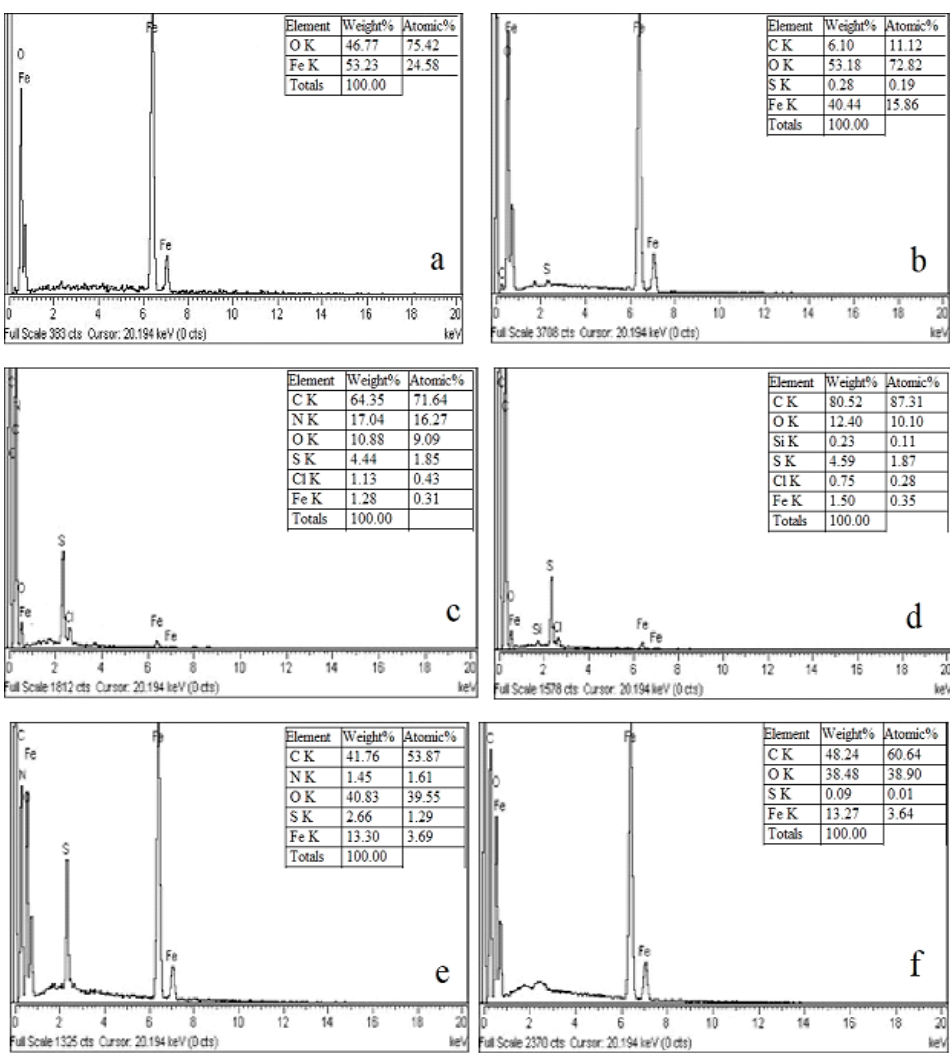
Figure 4. EDX of Fe 3 O 4 , PANI, and PANI / Fe 3 O 4 before ( a , c , e ) and after ( b , d , f ) adsorption of BB3.